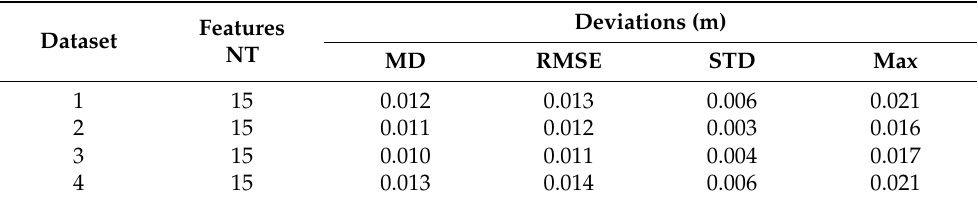
Table 4. Vertical accuracy. The ‘Dataset’ column represents the dataset index. The ‘Features’ column gives the number NT of the detected points in each dataset. The deviation is calculated as the vertical distance between the corresponding features from the TLS and UAV data.